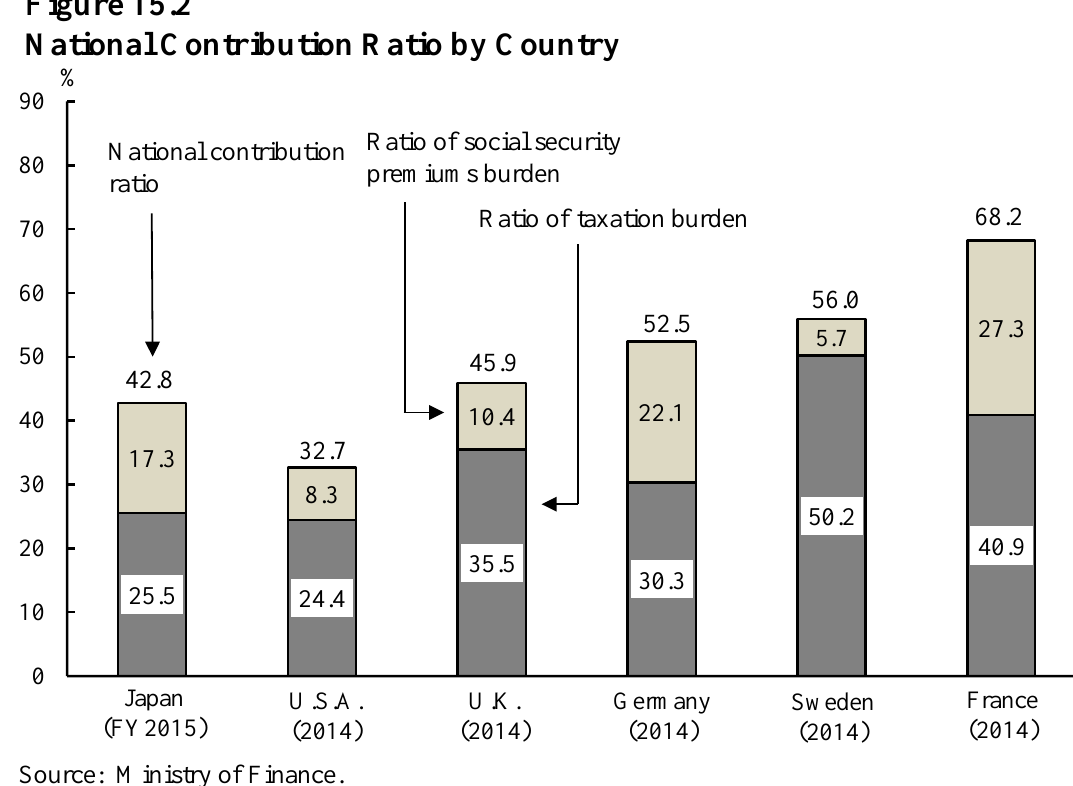
Figure 15.2 National Contribution Ratio by Country